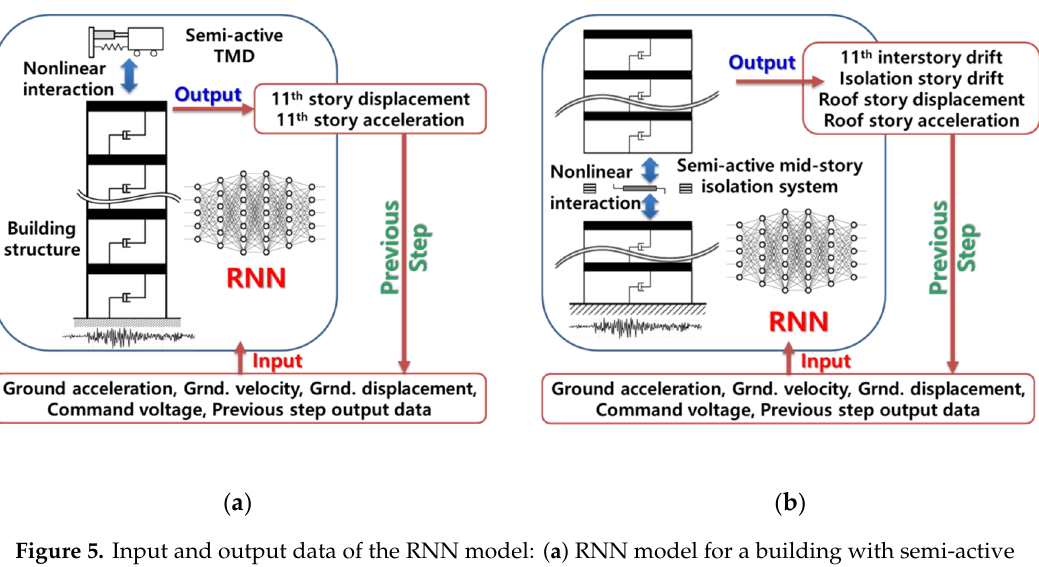
Table 2. Earthquakes for the training and verification of RNN.